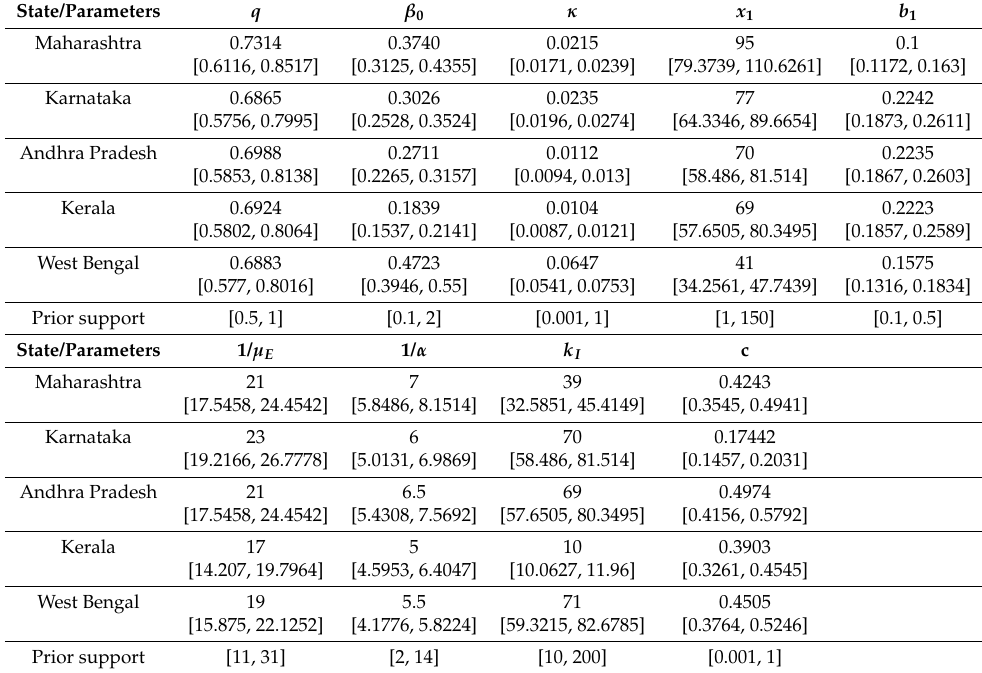
Table 2. The posterior mean, the associated 95% credible intervals, and the corresponding prior support for the unknown